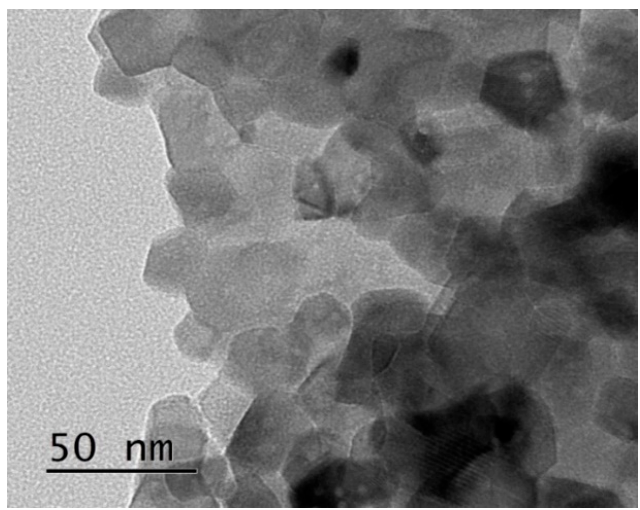
Figure 1. TEM micrograph of Co-doped ZnO NPs.